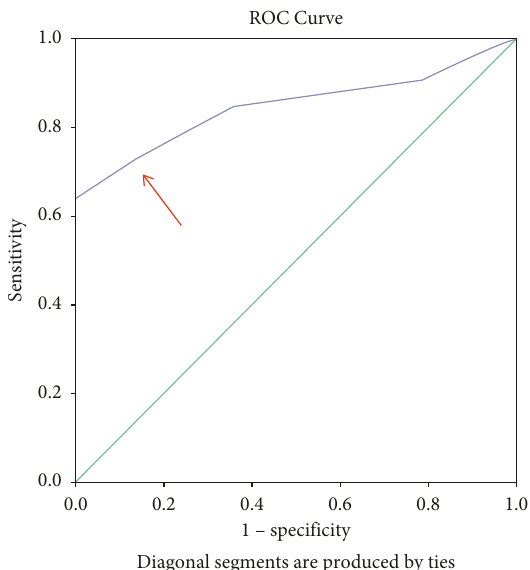
Figure 1: ROC curve 1 shows where to determine the cutoff for easy and difficult categories.